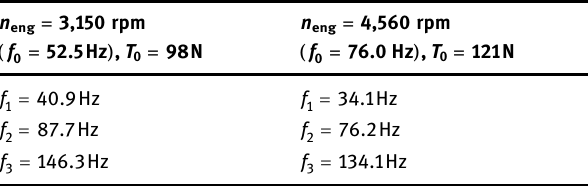
Table 2: Natural frequencies of moving belt ( approximation formula